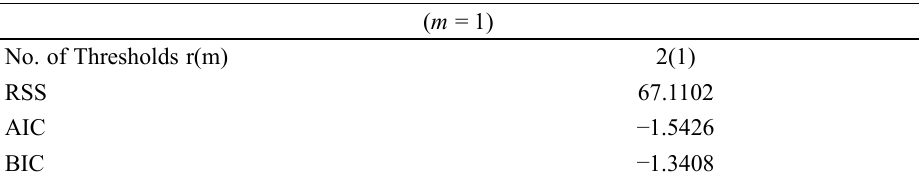
Table 9. Determination of the number of regimes for small to medium-sized